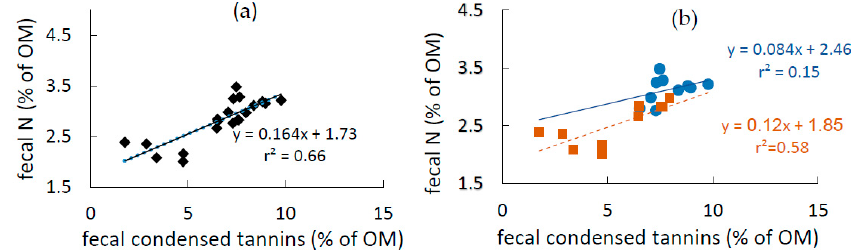
Figure 5. The relationship between monthly averages of fecal N and condensed tannins in ( a ) the whole oryx population ( ♦ ) or ( b ) analysed separately by release site: Paran ( ■ , ---) and Arava ( ● , ⸻ ).